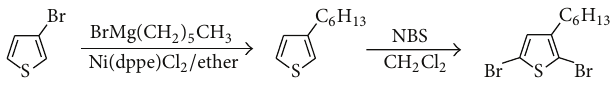
Scheme 2: Preparation of